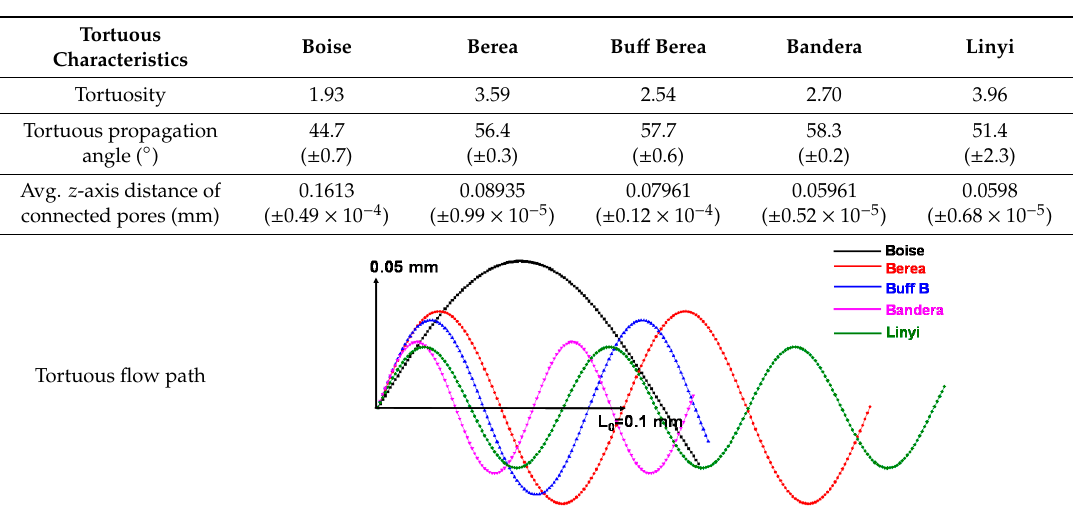
Table 9. Computational results of fluid pressure and velocity field in the pore channel model of Boise sandstone. The tortuosity, average distance and propagation angle of connected pores of ( a ) the total pore phase and ( b ) the apparent pore phase were applied to the 3D flow path